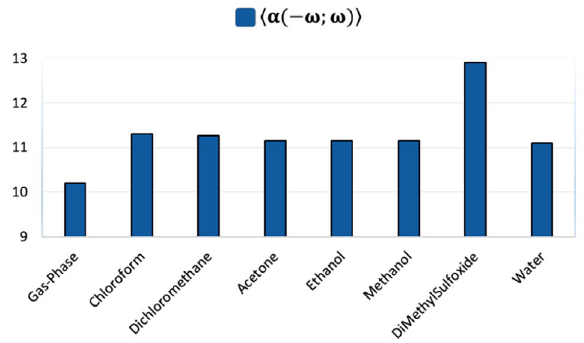
Figure 8: PCM-CAM-B3LYP/6-311++G(d,p) results for average linear polarizability ‹ α (– ω; ω )› (10 –24 esu ) for ω = 0.04282 of com-